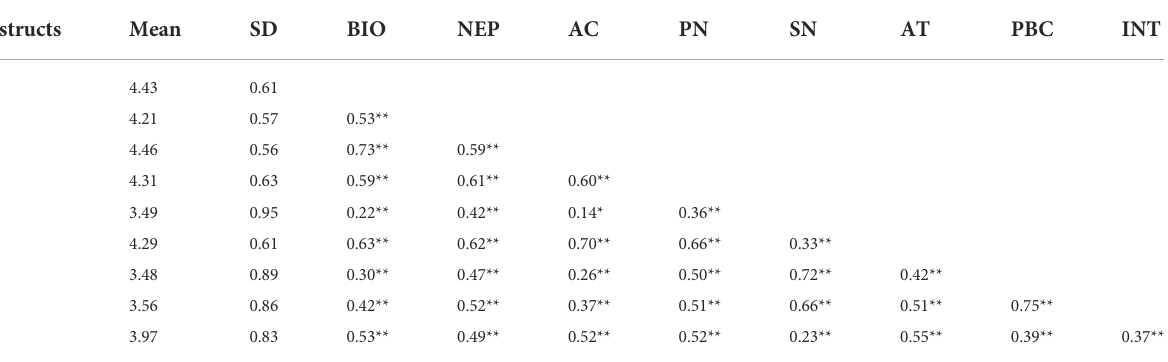
TABLE 1 Descriptive statistics and correlation